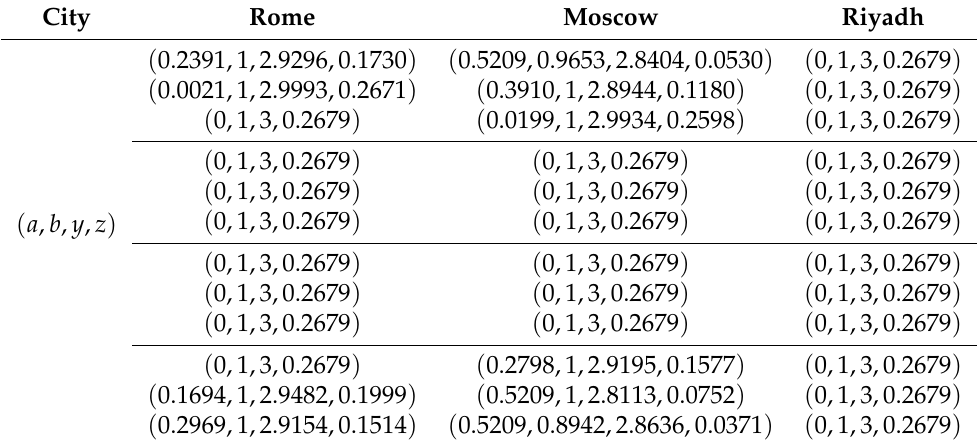
Table 3. Installation specification with respect to the south meridian altitude of each city. The azimuth angle is 17 π /18. Note that the data is aligned by month from the top (January) to the bottom